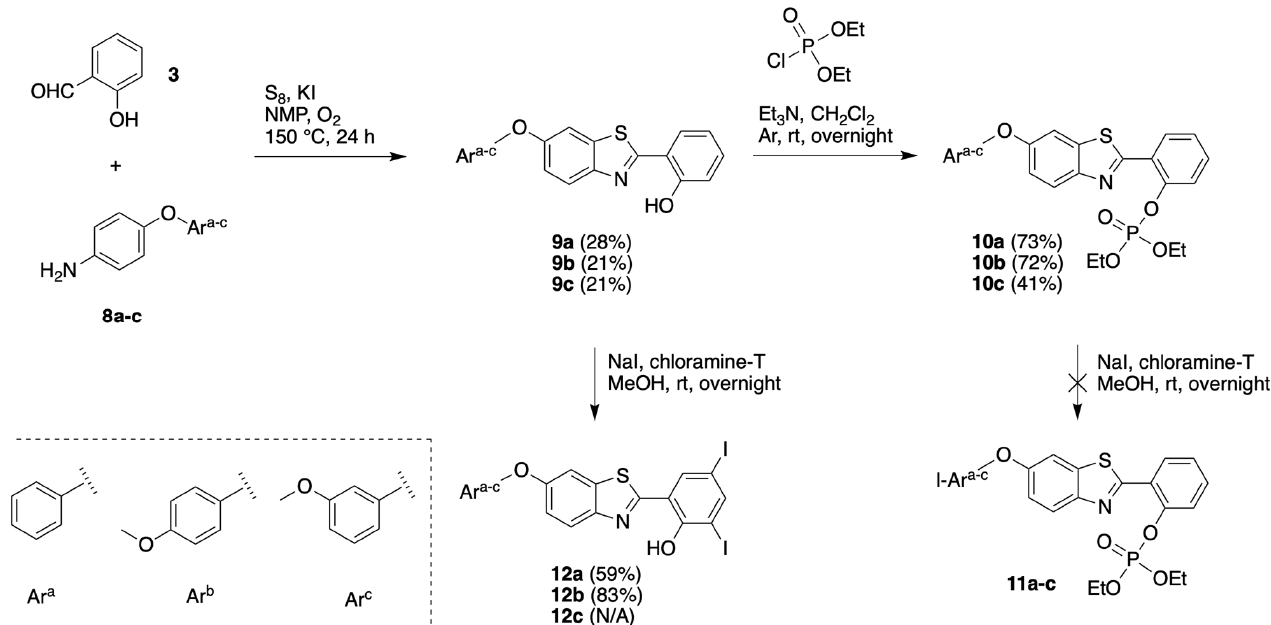
Scheme 5. Synthesis of HBT derivatives with an appended aryloxy